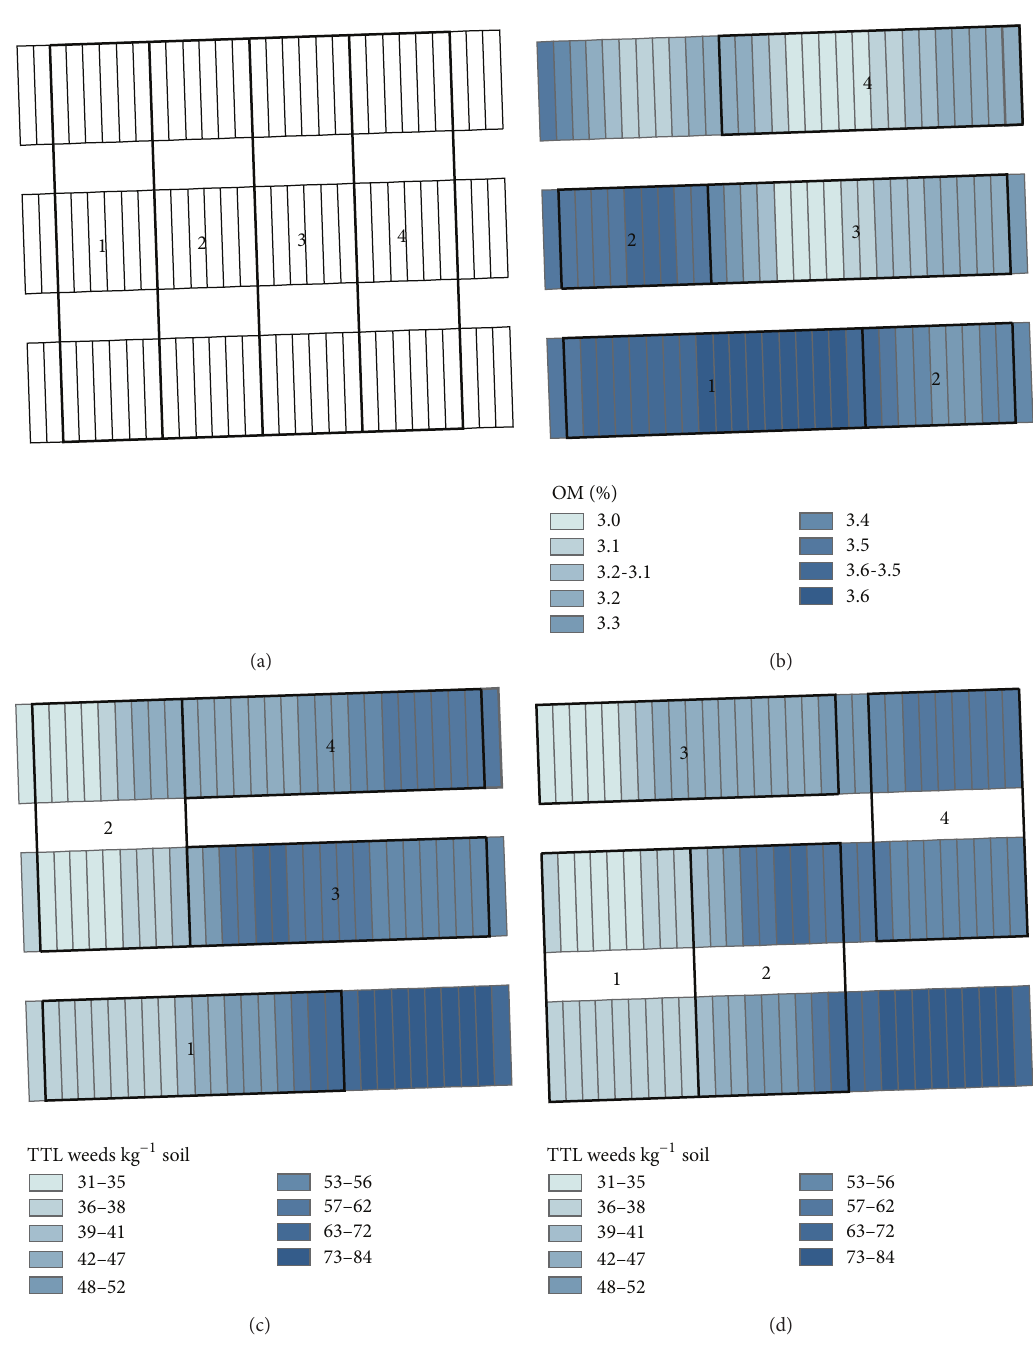
Figure 5: Subplot means for organic matter (b) and weeds (c-d) and four different blocking patterns evaluated for blocking efficiency with power analysis: blocking from west to east (a), blocking to optimize organic matter (b), blocking to optimize weeds, version 1 (c), and blocking to optimize weeds, version 2 (d). TTL weeds = total weeds, OM = organic